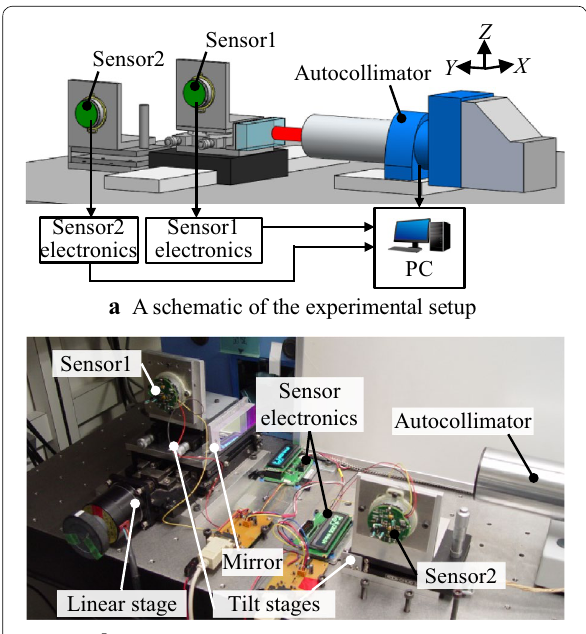
Figure 10 A setup for stage roll error